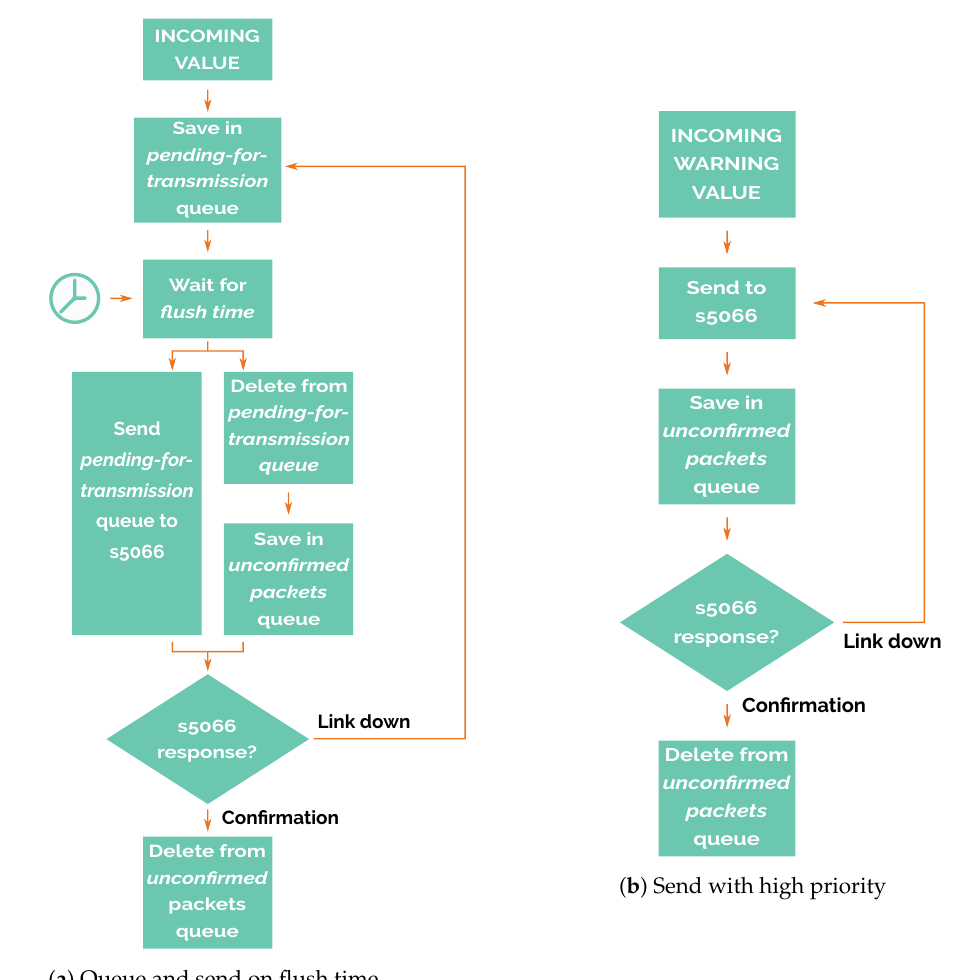
Figure 7. Preparation and transmission